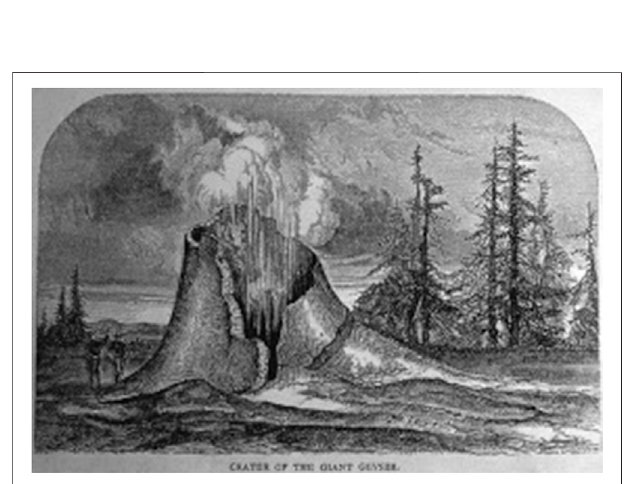
FIGURE 2 | Woodcut by Thomas Moran of the “ Giant ” geyser. Featured in Part 2 of Langford ’ s Wonders of the Yellowstone